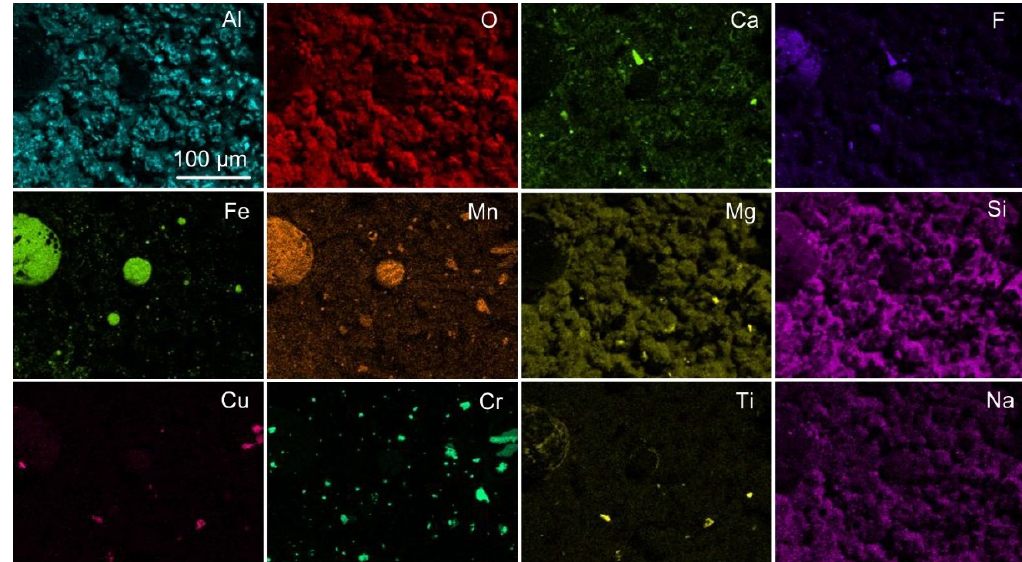
Figure 11. EDX map of marked area in Figure 10b: MP5 slag sample.